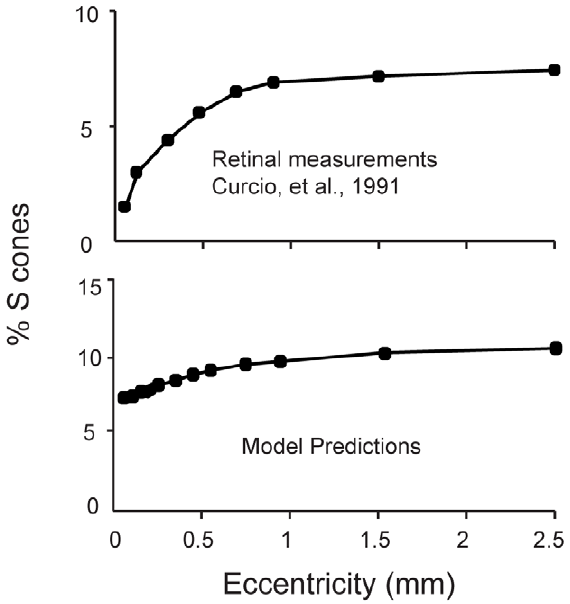
Figure 9. Optimal mosaic as a function of retinal eccentricity. (Top) Variation of measured S cone proportion with retinal eccentricity in human [1]. (Bottom) Proportion of S cones increases with eccentricity in the optimal